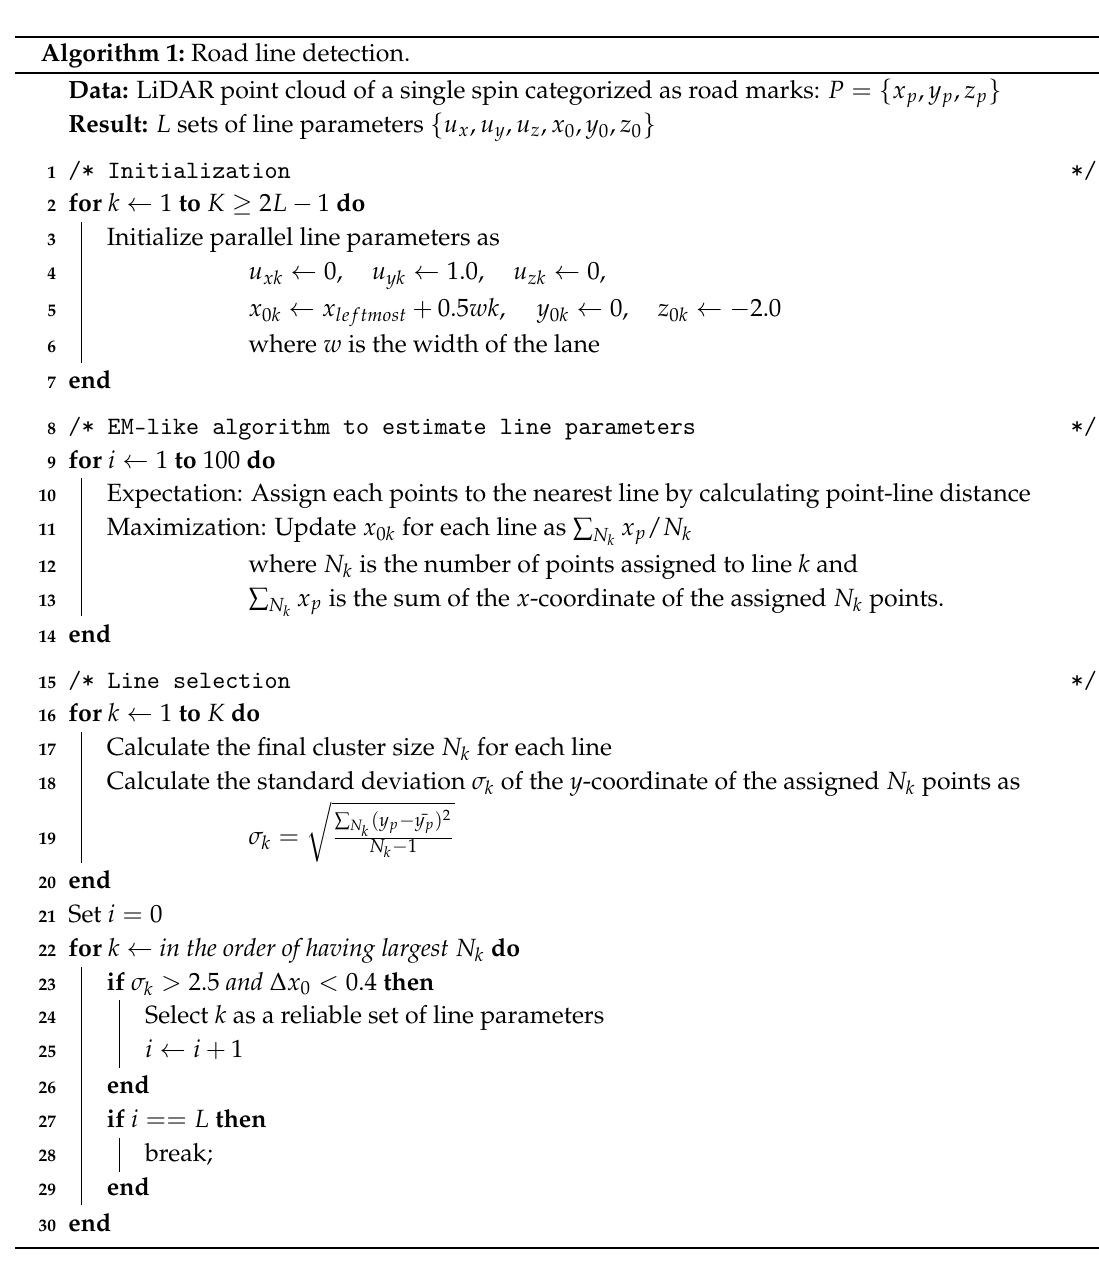
Algorithm 1: Road line